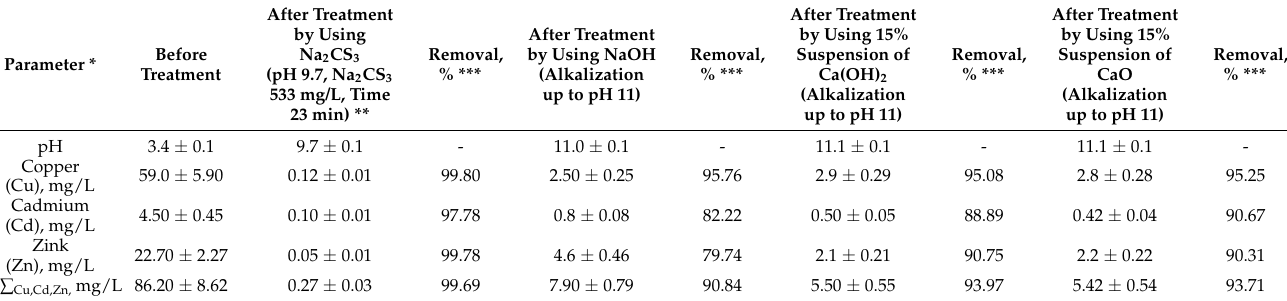
Table 7. Selected physicochemical parameters of galvanic wastewater before and after